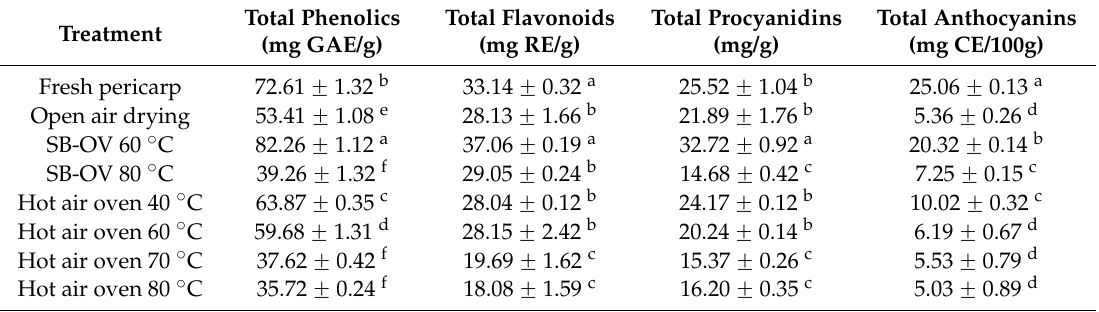
Table 1. Influence of treatment on total phenolic compounds, flavonoids, proanthocyanidins and anthocyanidins of litchi